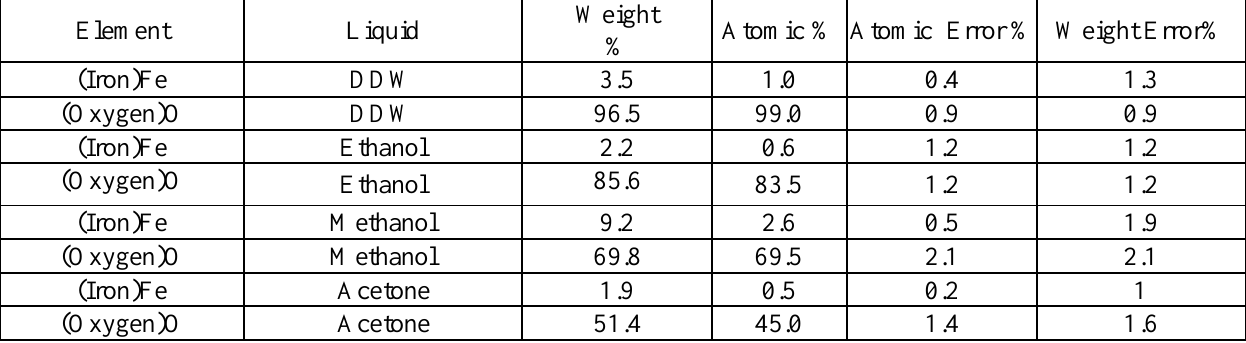
Figure 4: EDX spectra for iron oxide prepared by laser in different liquids, a-DDW, b-ethanol, c-Methanol, and d-acetone. Table 3: Summarize elements’ weight percentage and atomic ratios of the SPION NPs obtained from EDX results after ablation of Fe plate in liquids by